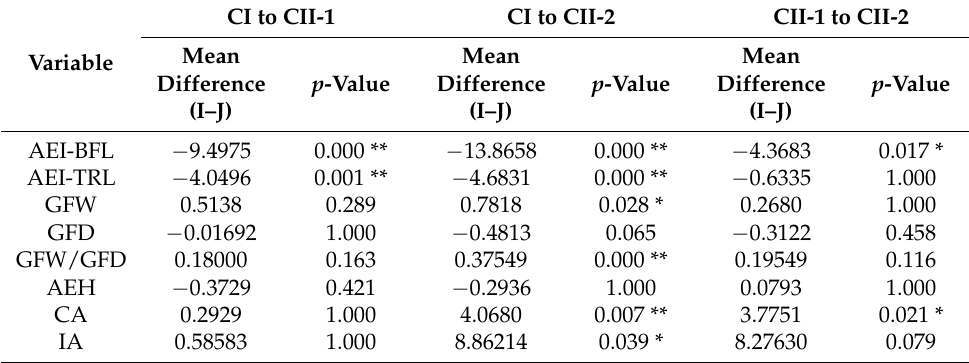
Table 3. Bonferroni test results for the measurements of the temporomandibular joint for the three